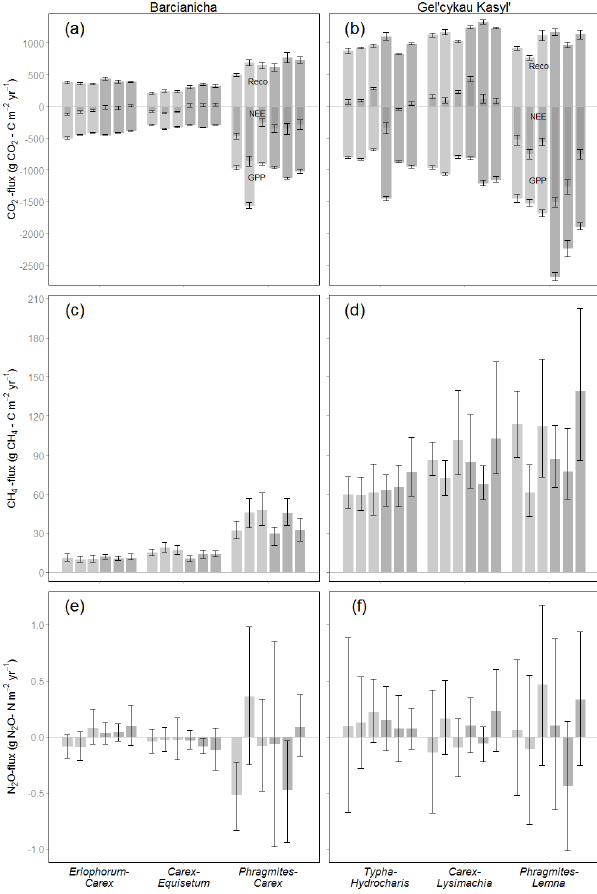
Figure 5. Annual CO 2 (NEE, R eco , GPP), CH 4 and N 2 O fluxes at Barcianicha (a, c, e) and Giel’ˇcyka˘u Kašyl’ (b, d, f) . Uncertainties for CO 2 fluxes are 50% of the difference between both modelling approaches plus the 90% confidence intervals of the H approach. Uncertainties for CH 4 represent 90% confidence intervals of the models, but for N 2 O only 90% CI of the measured N 2 O fluxes. Light grey = 1st year, darker grey = 2nd year. Plots are ordered I, II, III.